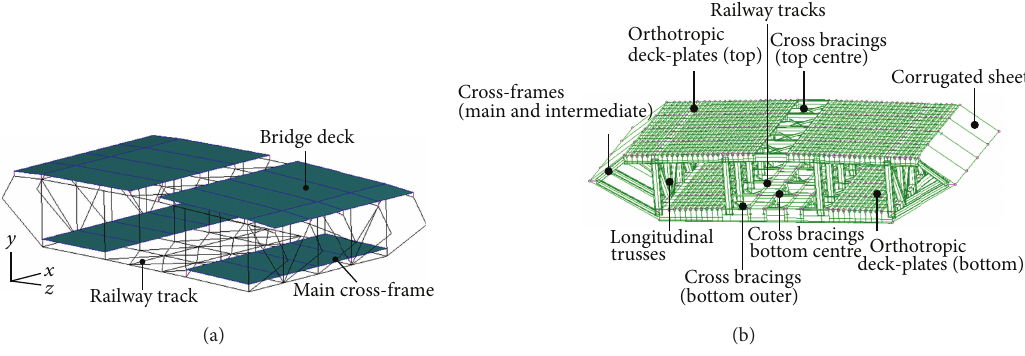
Figure 2: Finite element model of suspended deck module: (a) hybrid 3D bridge model [22]; (b) full 3D model